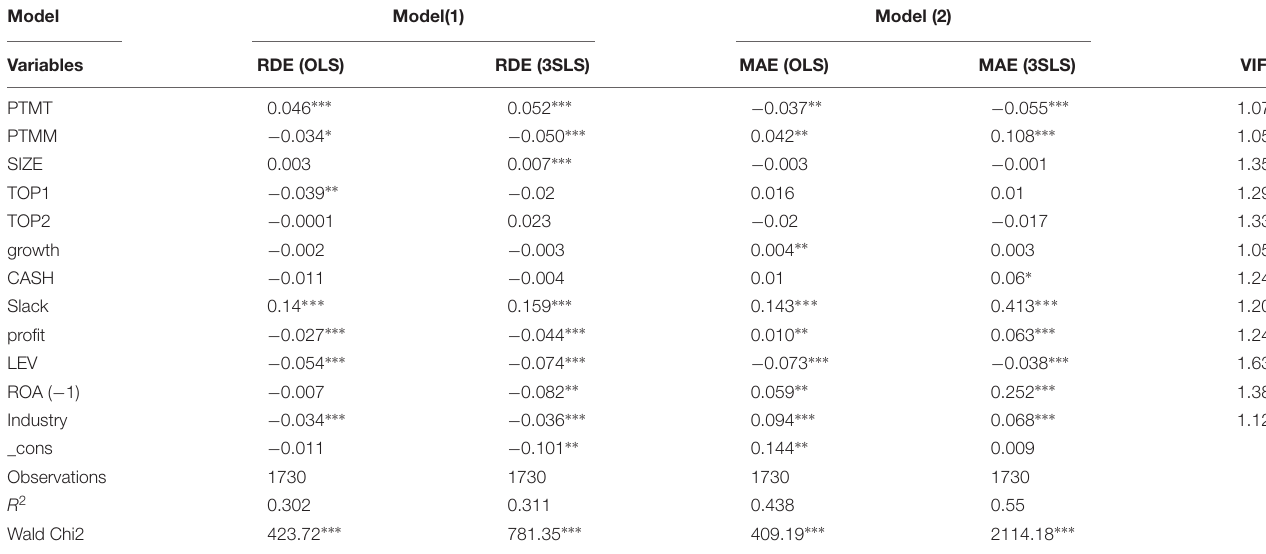
TABLE 2 | Results of main effect regression